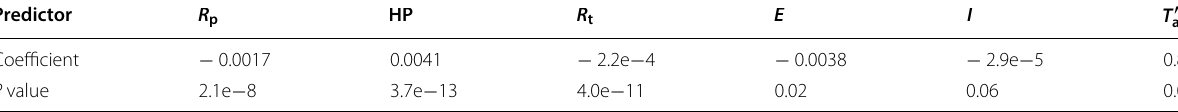
Table 3 Regression coefficients and statistical significance ( P values) of the selected predictors Predictor